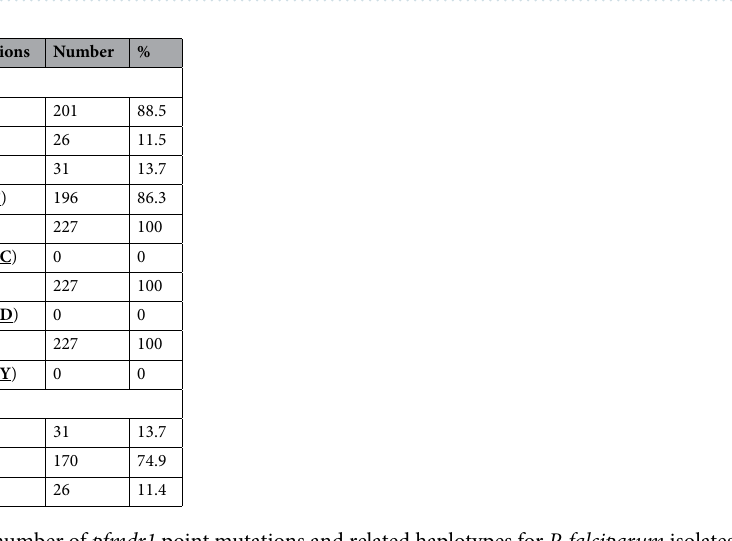
Table 2. Frequency and number of pfmdr1 point mutations and related haplotypes for P. falciparum isolates from Jazan, Saudi Arabia (n = 227). Mutant alleles are bold and underlined.